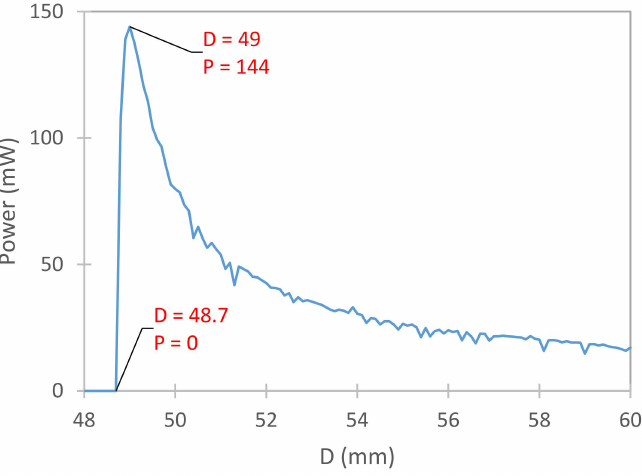
Figure 5. Graph Showing Variation of Power Output with Bluff Body Diameter D